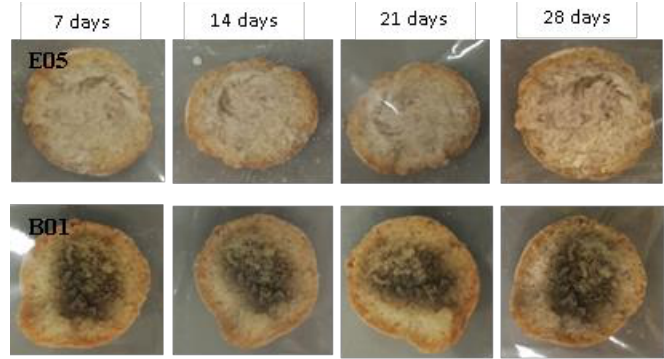
Figure 8. Examples of bread made from sourdoughs inoculated with the dual combination of isolates E05 and B01, and then artificially contaminated with Aspergillus niger and incubated at room temperature for 7, 14, 21, and 28 days.